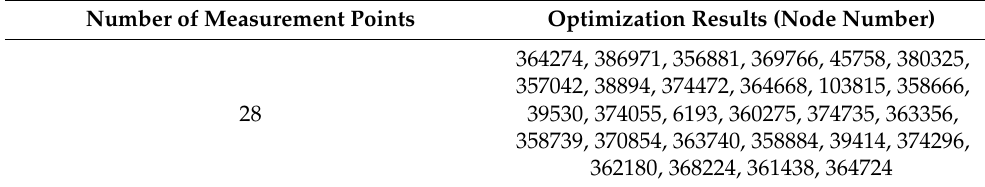
Table 5. Results of IPSOARW-based measurement point optimization for the bridge